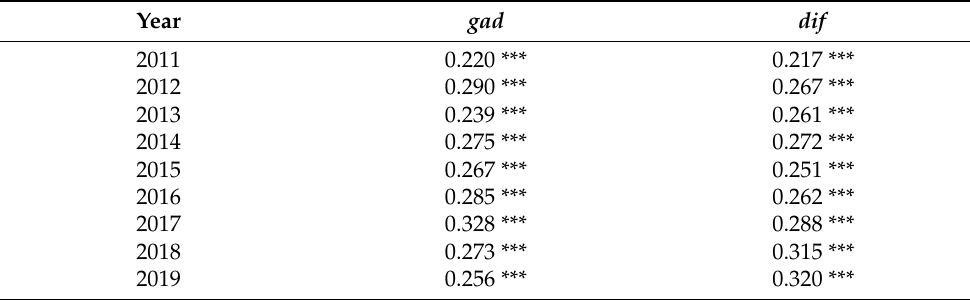
Table 4. Global Moran’s I index of digital inclusive finance and agricultural green